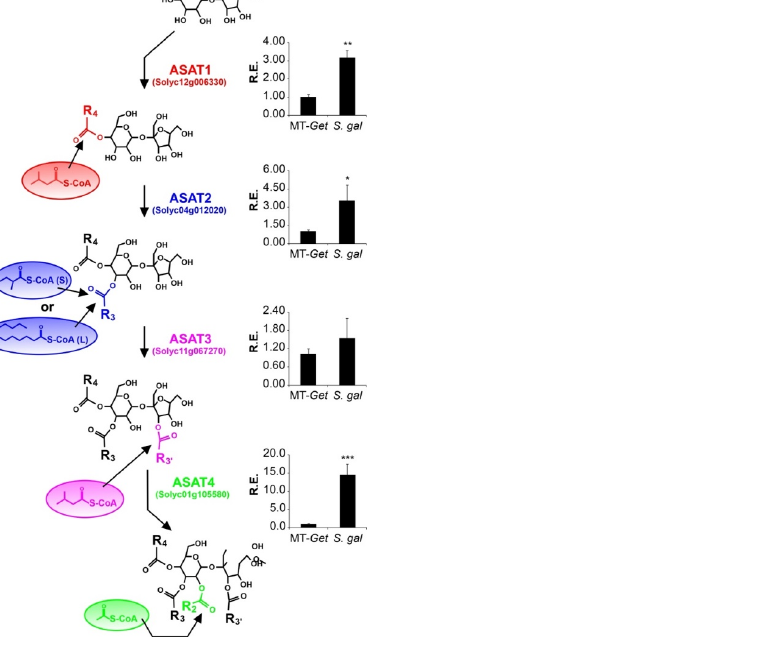
Figure 7. Relative expression of acylsugar acyltransferase ( ASAT ) genes in leaf tissues of MT- Get and S. galapagense . RT-qPCR values are means ± SE. Biological triplicates were averaged and ana- lyzed statically according to the Student’s t -test at p < 0.05 (*); p < 0.01 (**); p < 0.001